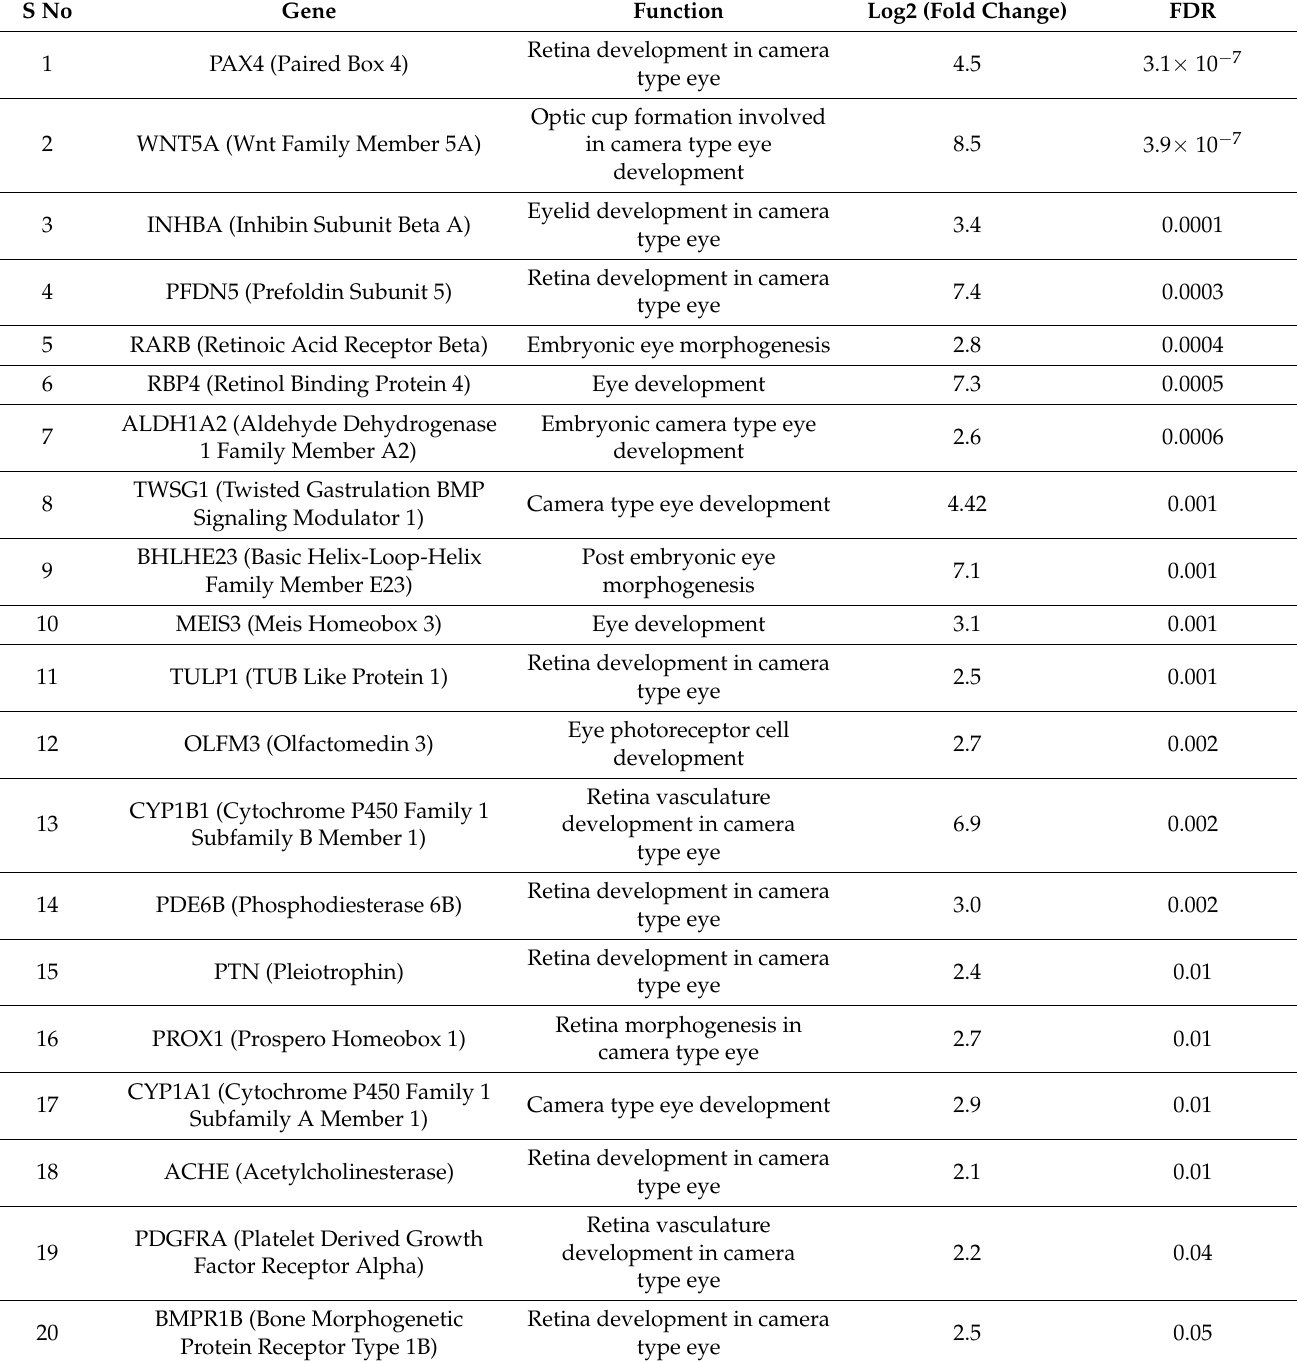
Table 1. Upregulated Retinoblastoma serum-derived small extracellular vesicles genes involved in ocular